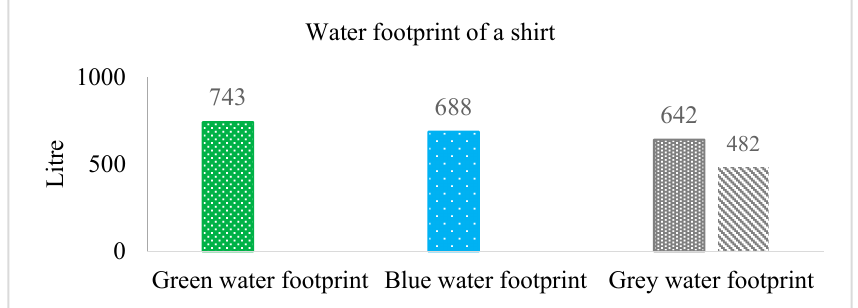
Figure 13. Water footprint of a shirt; with and without having functional ETP and STP the grey water footprint would be 482 L and 642 L, respectively.